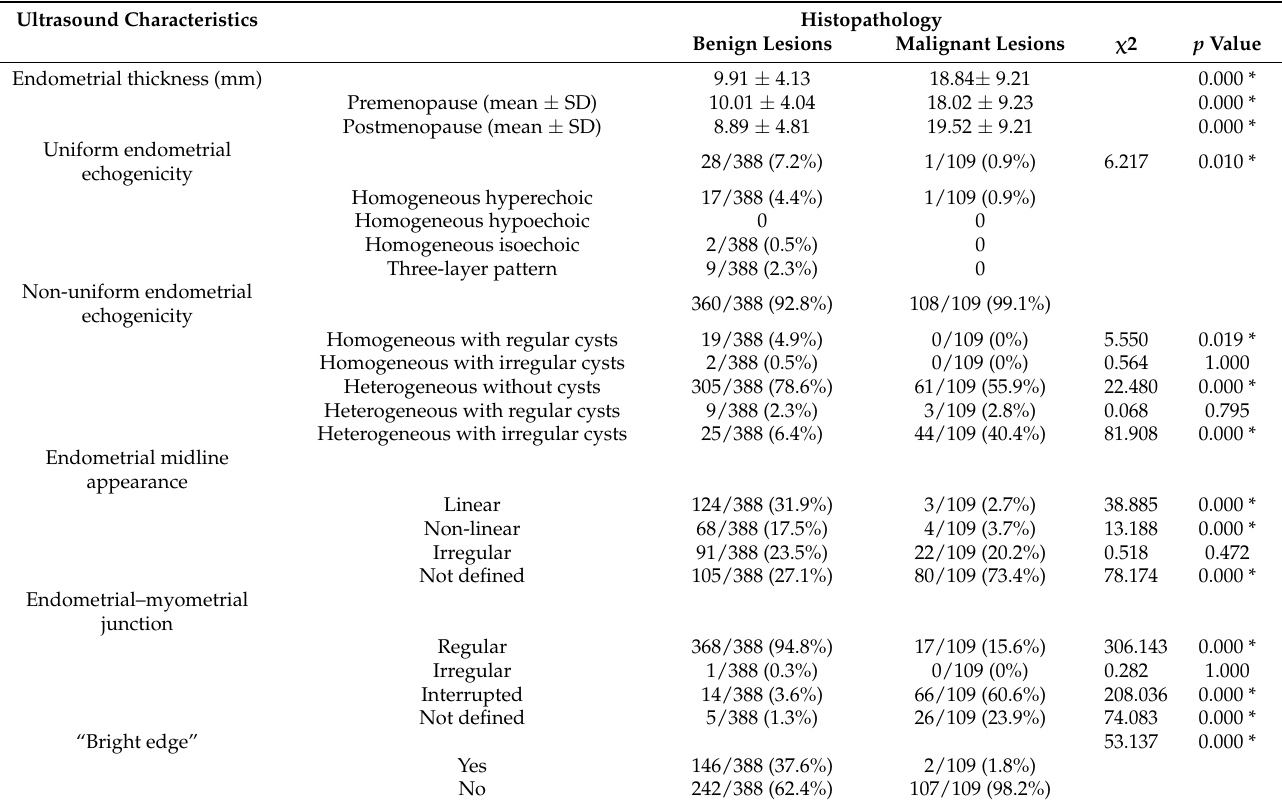
Table 1. Univariate analysis of IETA ultrasonic signs in differentiating benign and malignant uterine cavity and endometrial